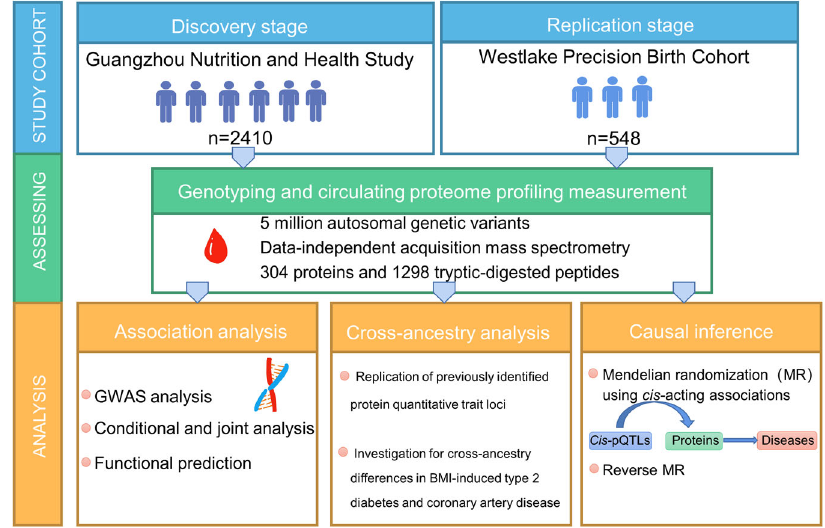
Fig. 1 | Overview of the study design. Using data-independent acquisition mass spectrometry, we measured serum proteome in up to 2410 Han Chinese partici- pants with replication in 548 Han Chinese women. A total of 1298 tryptic-digested peptidesand304proteinswereincludedintheanalysis.Weusedthecolocalization